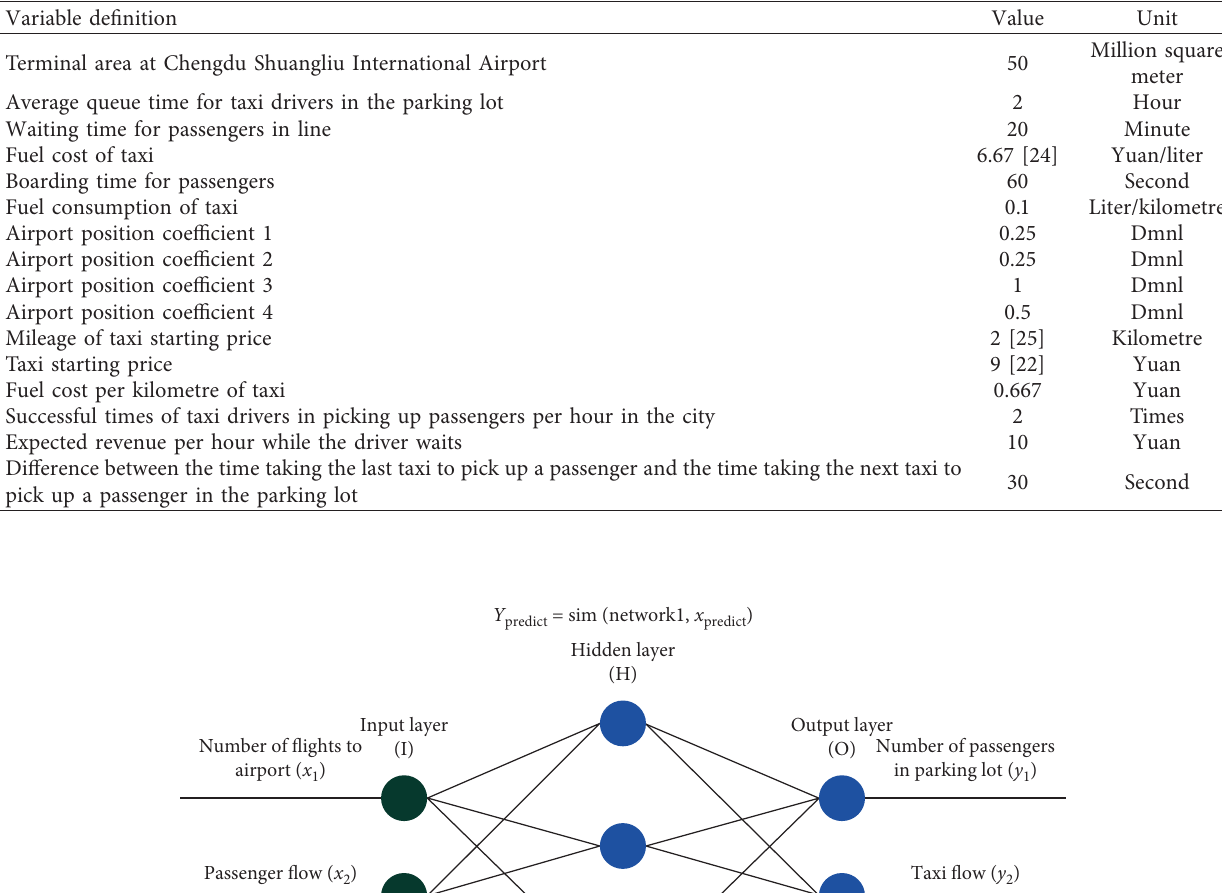
Table 2: Coefficient value of the decision-making model for taxi drivers.